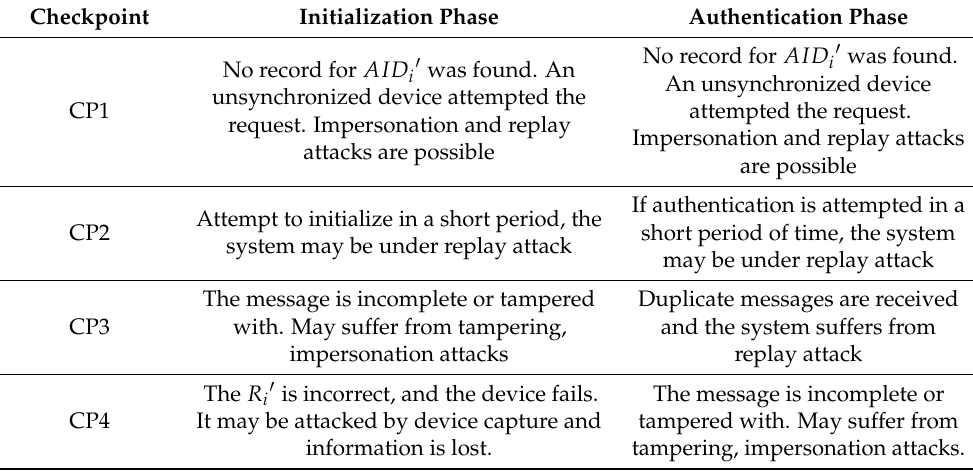
Table 2. Checkpoint validation failure description.